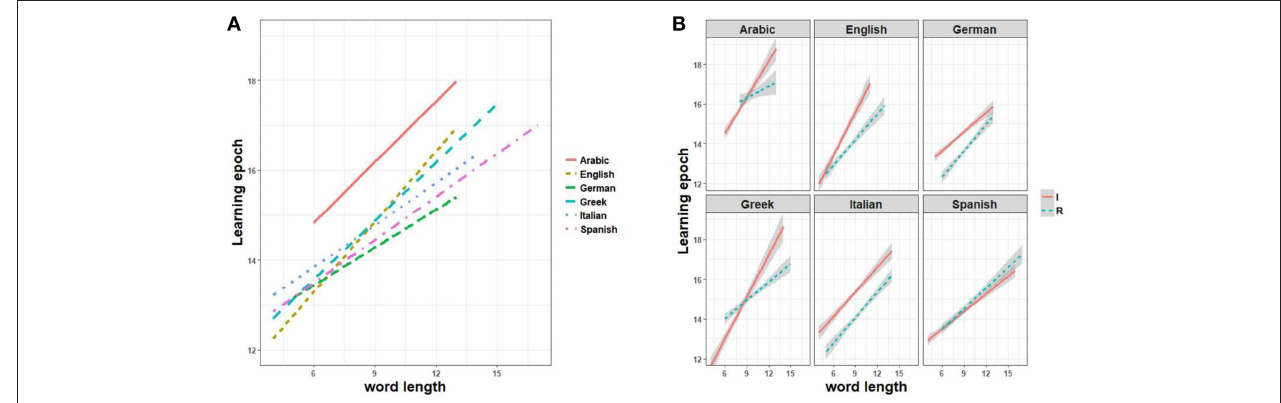
FIGURE 7 | Regression plots of time of lexical acquisition by word length, in linear interaction with (A) sample languages and (B) regular vs. irregular classification of paradigms plotted for each